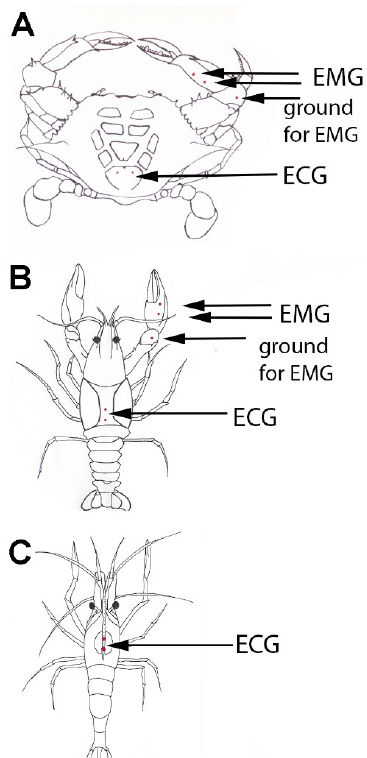
Figure 1. Placement of recording leads for measuring heart rate in an electrocardiogram (ECG) and skeletal muscle activity in an electromyogram (EMG) for the crab ( A ), crayfish ( B ) and shrimp ( C ). The two differential EMG leads to record the EMG activity of the closer muscle in the chela were placed ventrally in the propodite segment. A third lead is placed under the cuticle in any of the more proximal segments to serve as a ground lead. The ECG leads for the crab span the heart laterally for the best ratio in signal to noise for the recordings, and similar lead placements are made for the crayfish. The ECG leads for the crayfish and shrimp are placed in an anterior-posterior arrangement for obtaining the best signals. Modified figure from Wycoff et al. [53].